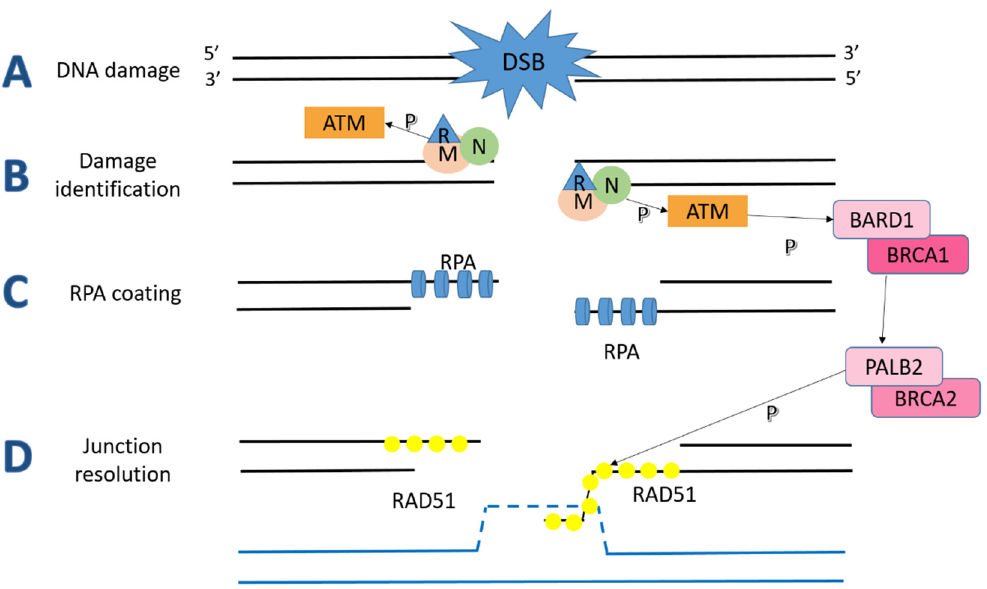
Figure 1. When a DSB occurs in the DNA ( A ), the MRN complex recognizes the damage ( B ) and starts 5 ′ strand degrada- tion to get a 3 ′ ssDNA free to be coated by RPA and ATM is activated by phosphorylation ( C ). The interaction of RPA and RAD51 repairs the damage with the support of BRCA1-BARD1 and BRCA2-PALB2 complexes ( D ).